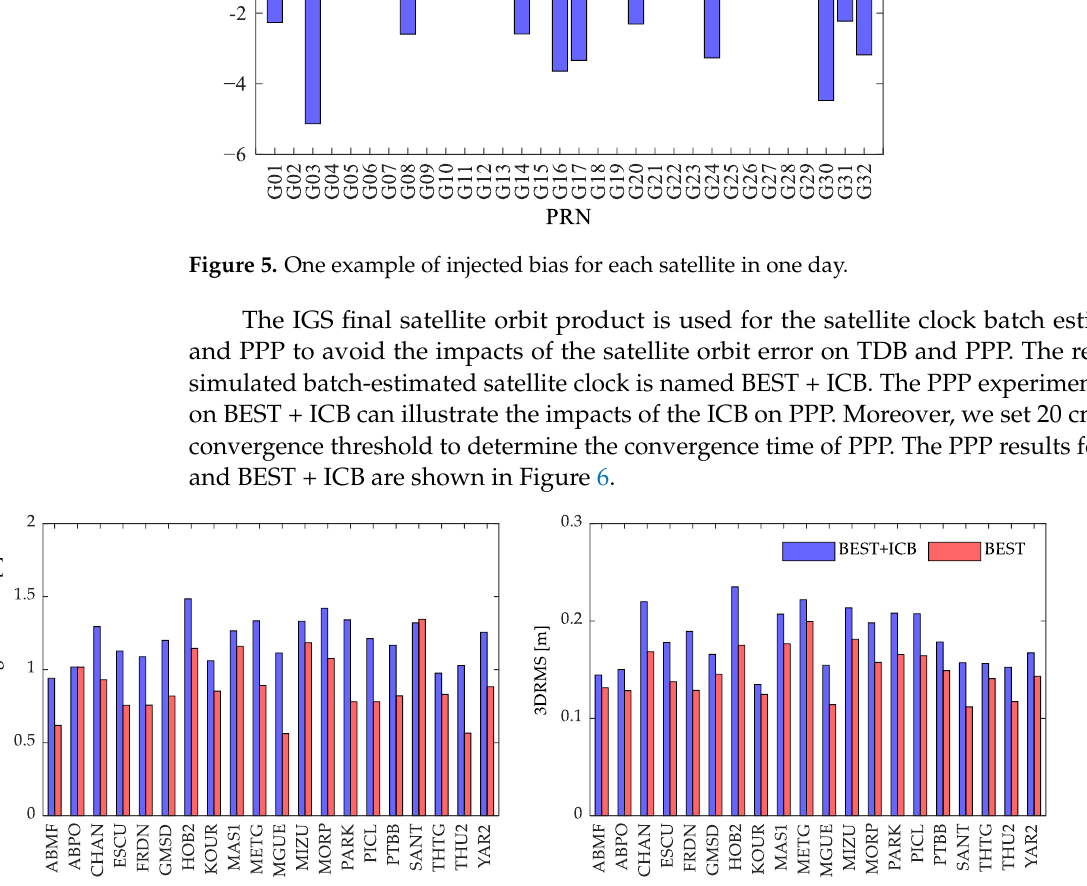
Figure 6. PPP results for BEST and BEST + ICB at 20 arbitrary stations for one year. The two subplots on the left show the STD of the convergence time. The two subplots on the right show the 3DRMS of the positioning accuracy after convergence.